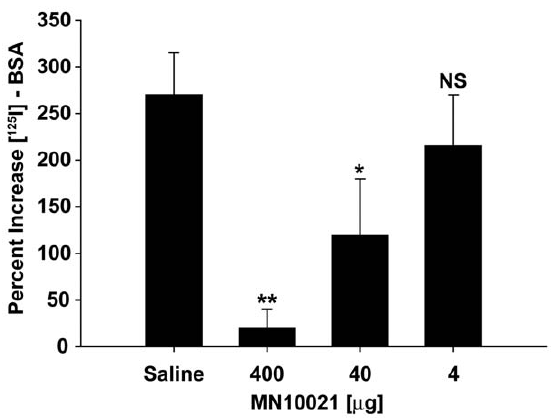
Figure 4. MN10021-mediated inhibition of vascular leak in murine DIC model. Two groups of 5 CD-1 mice (male, 6–8 weeks of age) were each injected i.p with 1.0 ml of either saline or 1.0 ml of the indicated dose of MN10021 in saline. Twelve hours later the mice were each injected i.v. with 0.25 ml of saline containing 10 6 cpm of [ 125 I]-BSA followed by an i.p. injection of 1.0 ml of either saline or 1.0% measurements made. ** p , 0.01; * p , 0.05; NS = not significant.